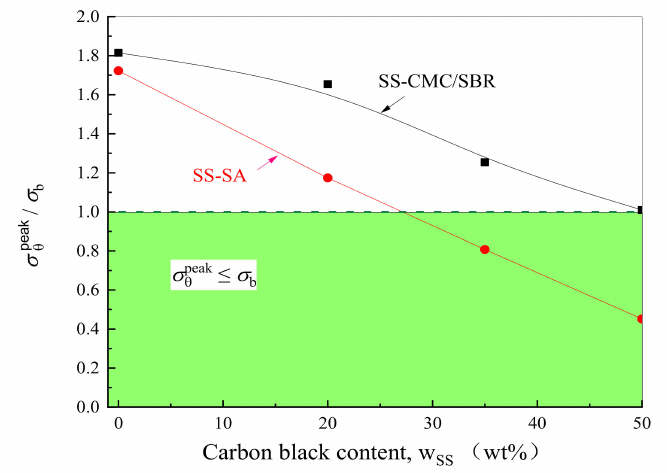
Figure 6. Mechanical integrity of BCC with di ff erent carbon black contents and aqueous